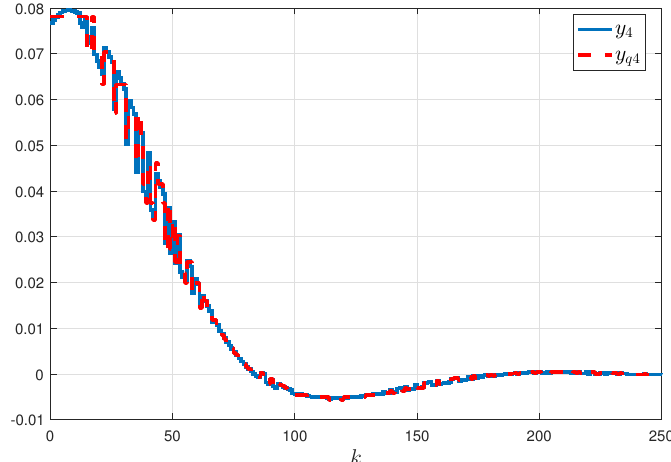
Figure 5. Actual output, y 4 , and quantized output, y q 4 .